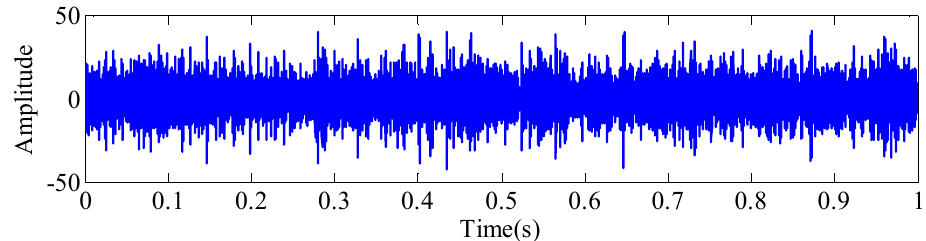
Figure 26. Time domain diagram of the signal segment selected by the algorithm in this paper.